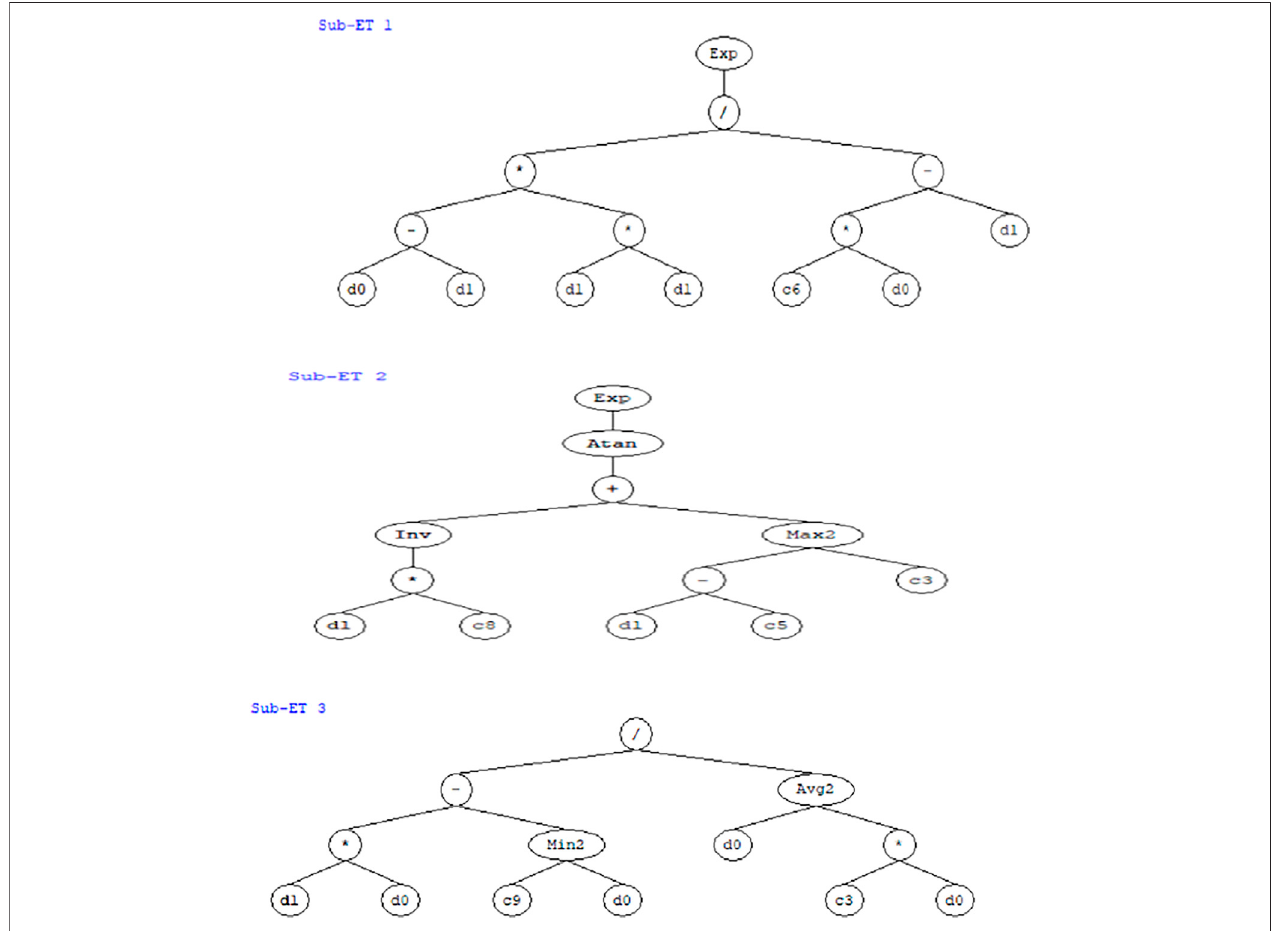
FIGURE 3 | The expression tree of PSR was obtained from the genetic programing software Genexpro 5.0 (d1: IRI, d0: PCI).